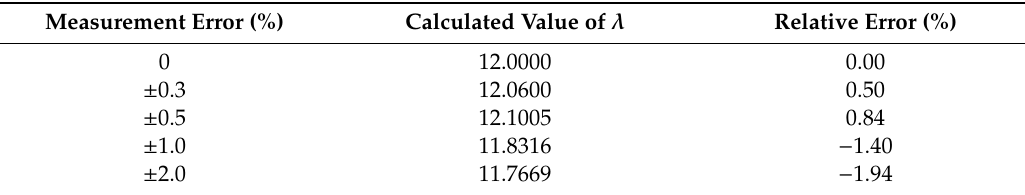
Table 2. The value of λ and the relative